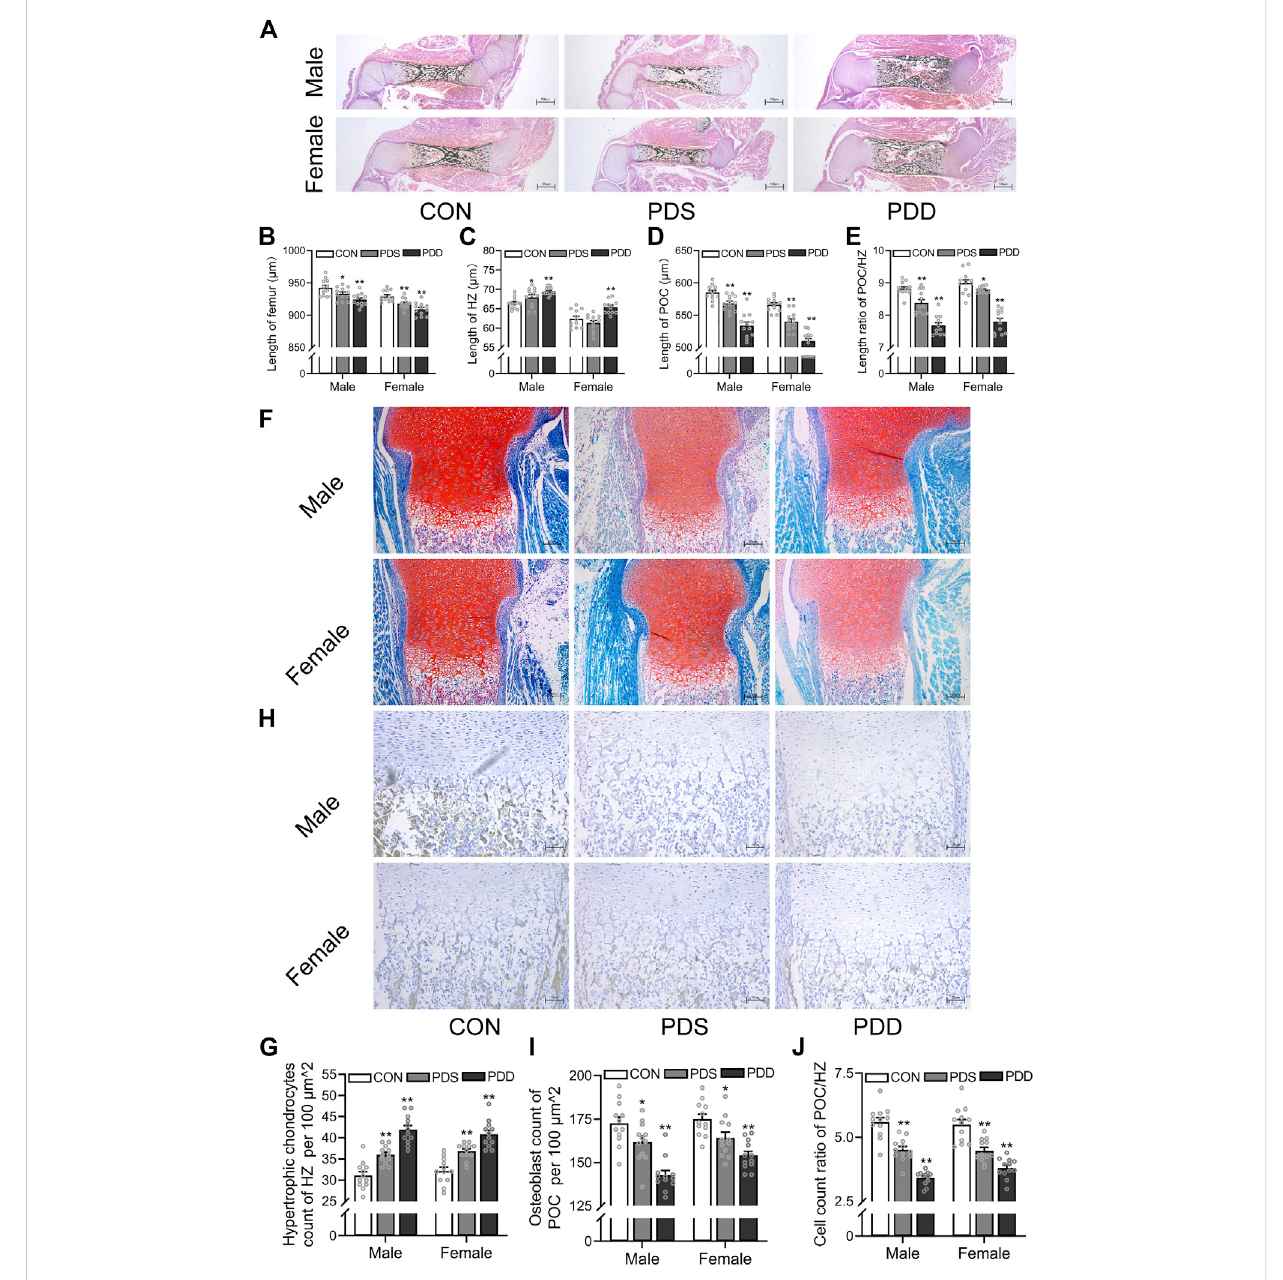
Effects of different courses of dexamethasone exposure on bone development and chondrocyte-to-osteoblast trans-differentiation in fetal mice. (A) . Typical images of vonkossa staining in fetal bone tissue; (B) . Quantitative analysis of fetal femur length; (C) . Quantitative analysis of the width of hypertrophy zone (HZ) in growth plate; (D) . Quantitative analysis of the length of primary ossi fi cation center (POC); (E) . The ratio between the length of POC and the width of HZ in growth plate cartilage; (F) . Typical images of fetal bone tissue stained with saffron O and solid green; (G) . Analysis of hypertrophicchondrocytesnumberingrowthplatecartilage; (H) .Typicalimagesofalkalinephosphatase(ALP)staininginfetalbonetissue; (I) .Analysisof osteoblastsinthePOC; (J) .TherelativeratioofthenumberofosteoblastsinPOCtothenumberofhypertrophiccellsingrowthplatecartilage.* p < 0.05 , **p < 0.01 , CON v.s. PDS or PDD. CON, control; PDS, single course of dexamethasone exposure during pregnancy; PDD, double course of dexamethasone exposure during